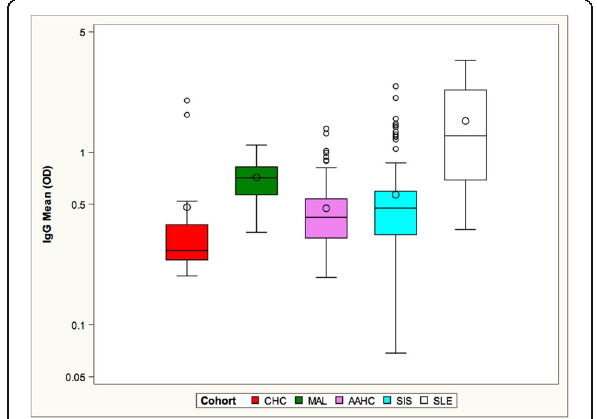
Fig. 2 The SLE and MAL cohort had significantly higher mean IgG anti-DNA levels than all other cohorts. The CHC, AAHC and SIS cohorts did not differ from one another and had lower titers than the MAL and SLE cohorts